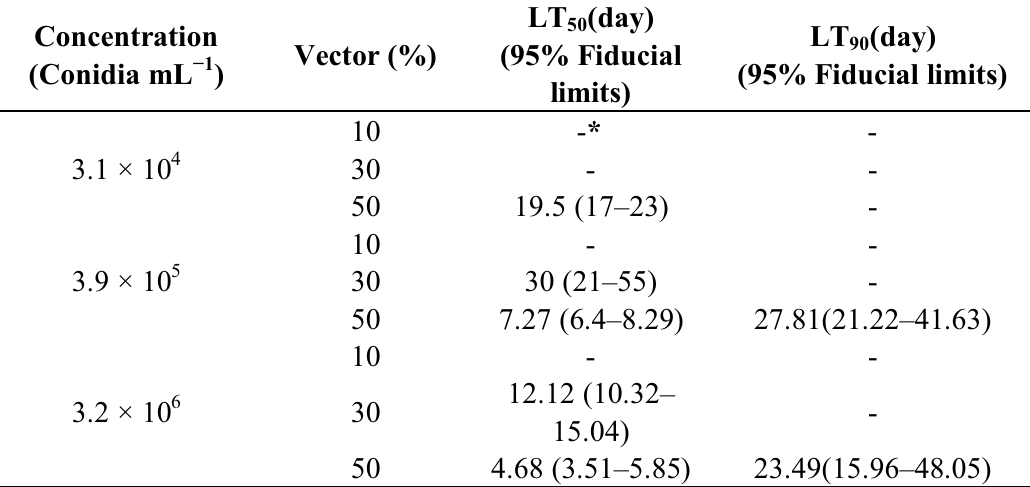
and LT for different treatment 50 90